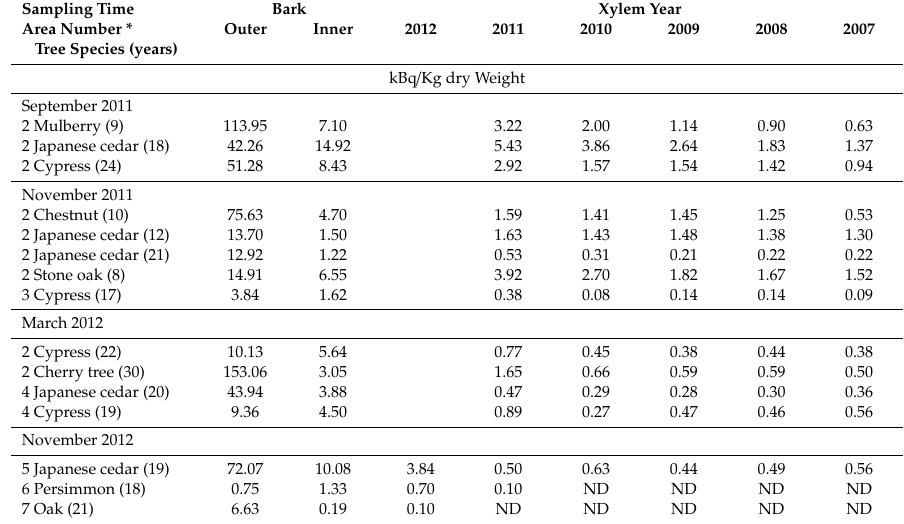
* Area numbers are shown in Figure 1. All the vascular cambium zones were removed. Individual values represent the means of three independent samples for each year ring with individual values varying from the mean by < 5.1%. ND, not detected.